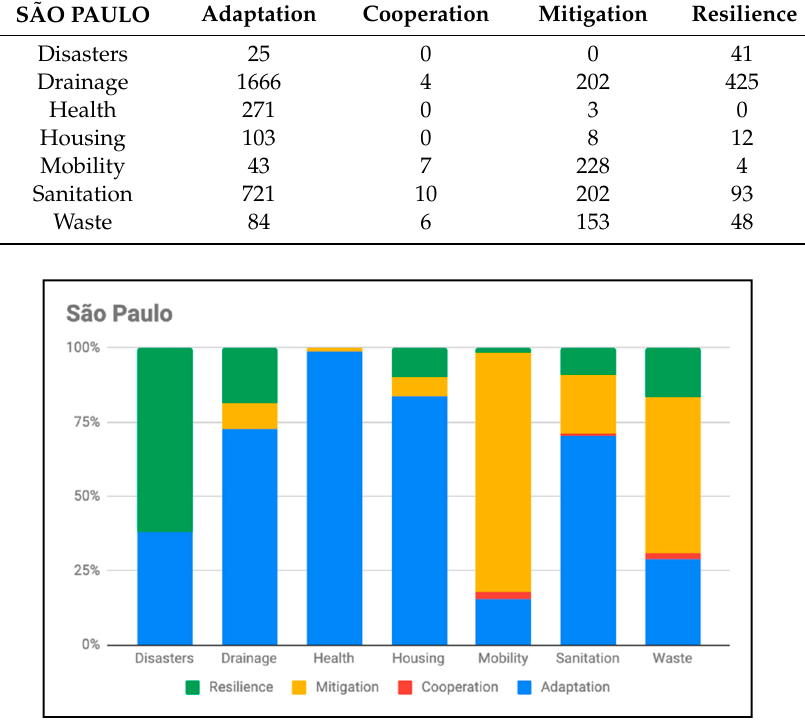
Figure 14. Climate action references in São Paulo’s sectoral plans.